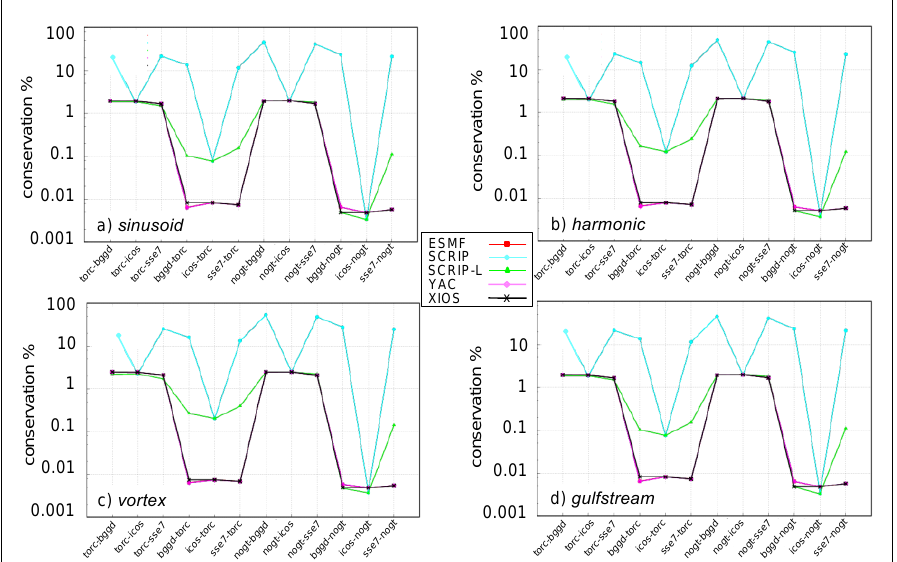
Figure 10. Source global conservation (%) for ESMF, SCRIP, SCRIP-L, YAC and XIOS for the 1st order conservative remapping with DESTAREA normalisation for the different pairs of grids for the 4 functions: ( a ) sinusoid , ( b ) harmonic , ( c ) vortex , and ( d ) gulfstream.